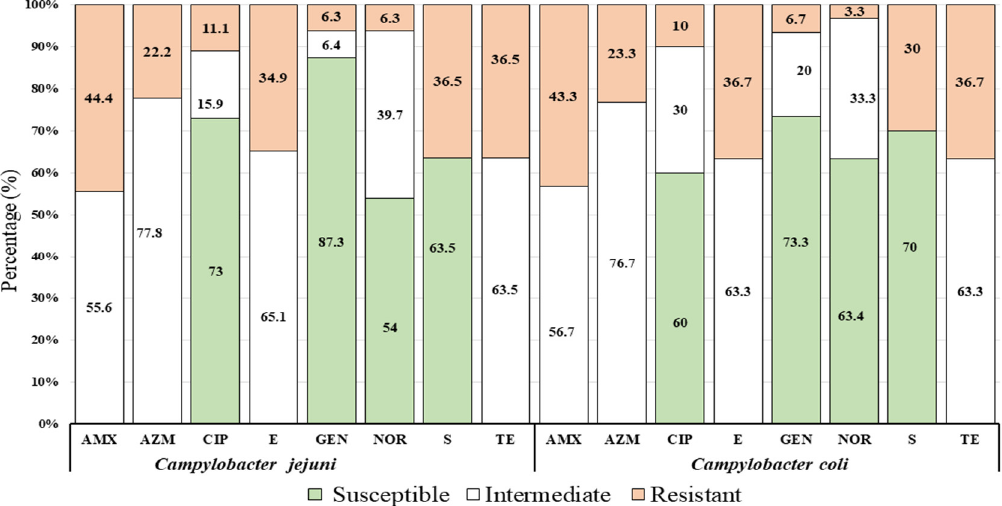
Figure 3. Proportion of antimicrobial susceptibility profile of Campylobacter spp. ( C. jejuni and C. coli ) against common eight (8) antimicrobial agents with standard doses (µg): Amoxicillin (AMX, 30 µg), Azithromycin (AZM, 30 µg), Ciprofloxacin (CIP, 5 µg), Erythromycin (E, 30 µg), Gentamycin (GEN, 10 µg), Norfloxacin (NOR, 10 µg), Streptomycin (S, 10 µg), and Tetracycline (TE, 30 µg) showed in three groups (susceptible, intermediate, and resistant) of the resistant pattern in accordance to Clinical and Laboratory Standards Institute [30].